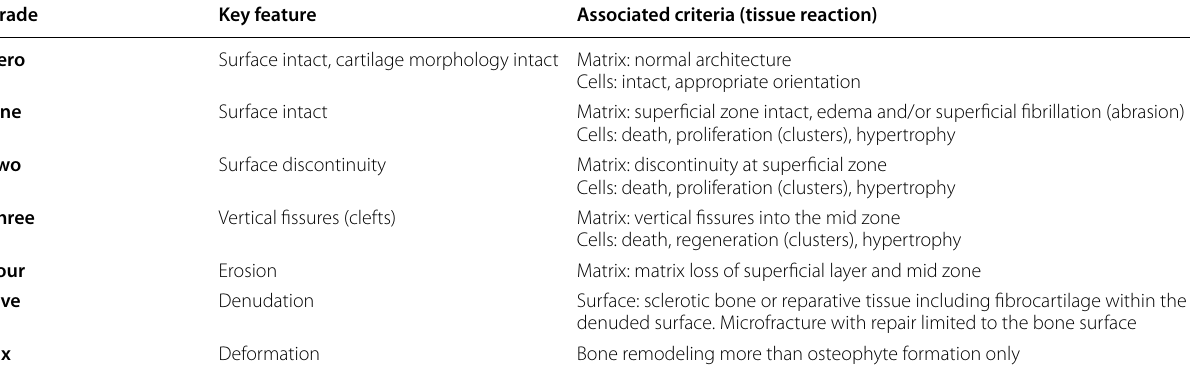
Table 1 Key feature of different grades based on the Osteoarthritis Research Society International scoring system Grade Key